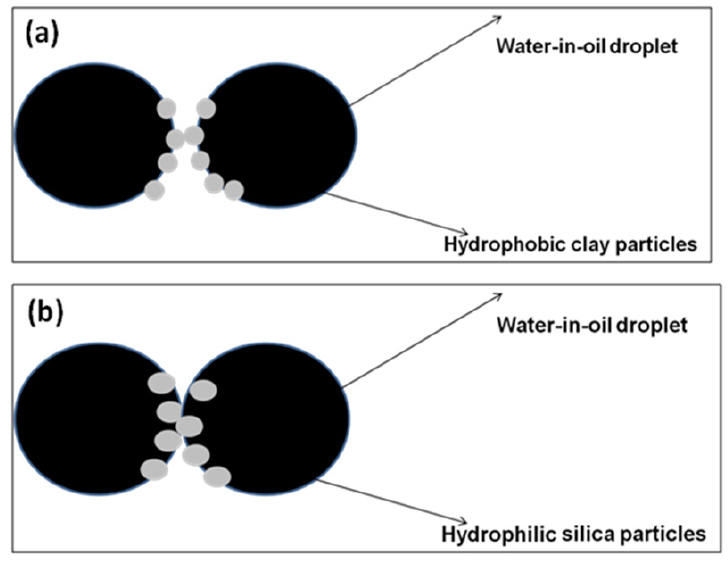
Figure 13. Schematic mechanisms of kaolinite and silica stabilized